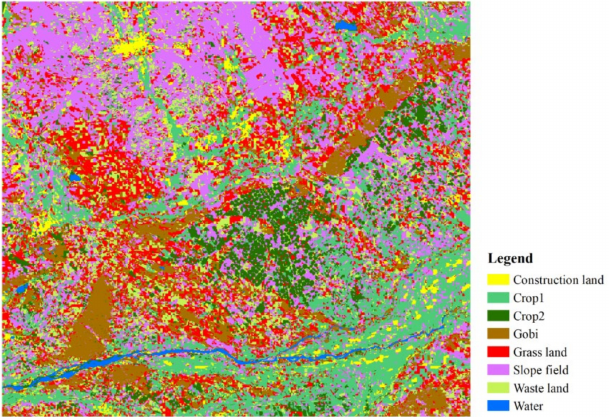
Figure 11. Classification result of the ESTARFM predicted time-series data in AHB dataset. ( a ) is the classification result of an objected-oriented method with the SVM classifier (i.e., LC4), and ( b ) is the classification result of the ED-similarity measure method (i.e., LC5).